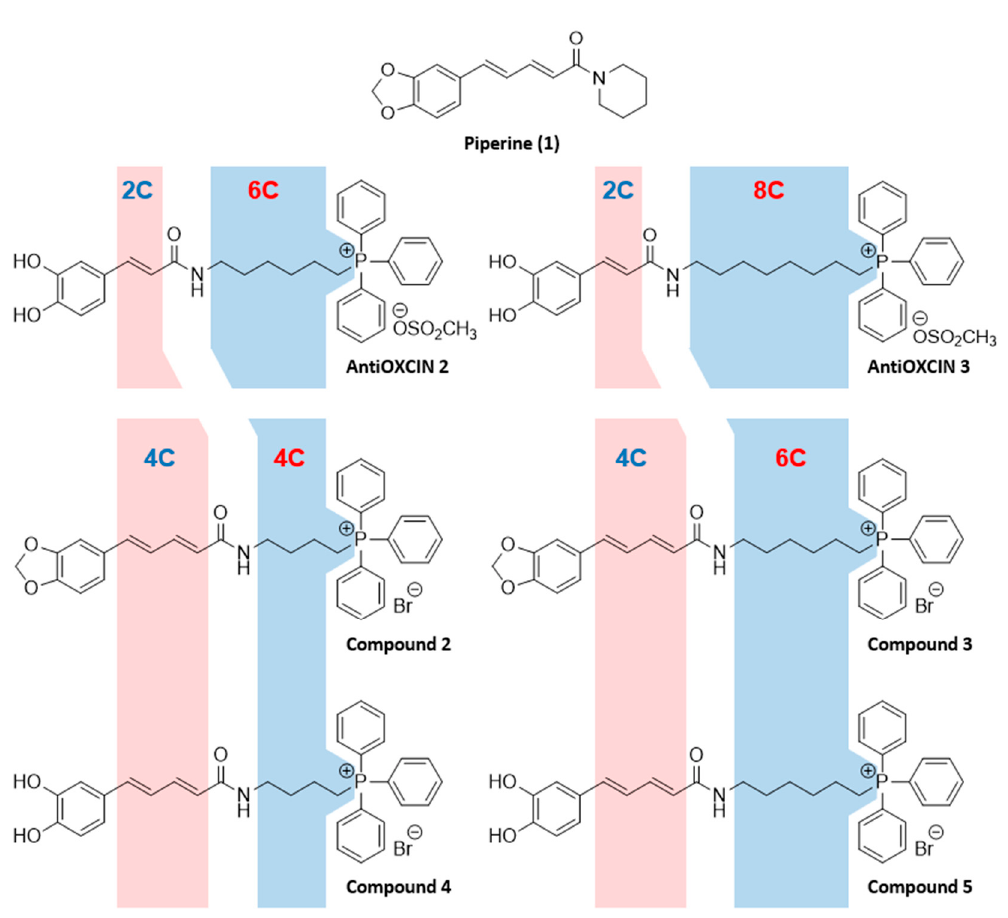
Figure 1. Rational design of mitochondria-targeted compounds 2 – 5 based on AntiOXCIN2, AntiOXCIN3, and piperine (compound 1 ).